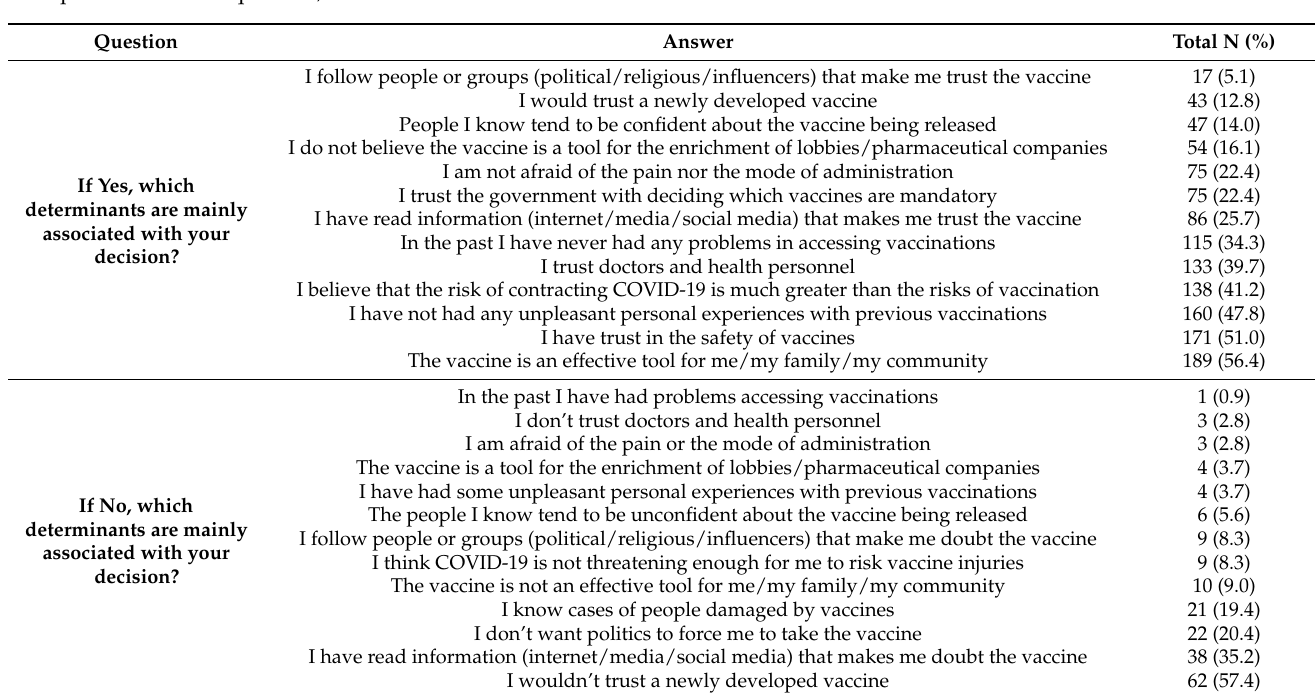
Table 2. Reasons for willingness to receive COVID-19 vaccination in Bologna and Palermo. More than one answer was possible for each question, with no limit.